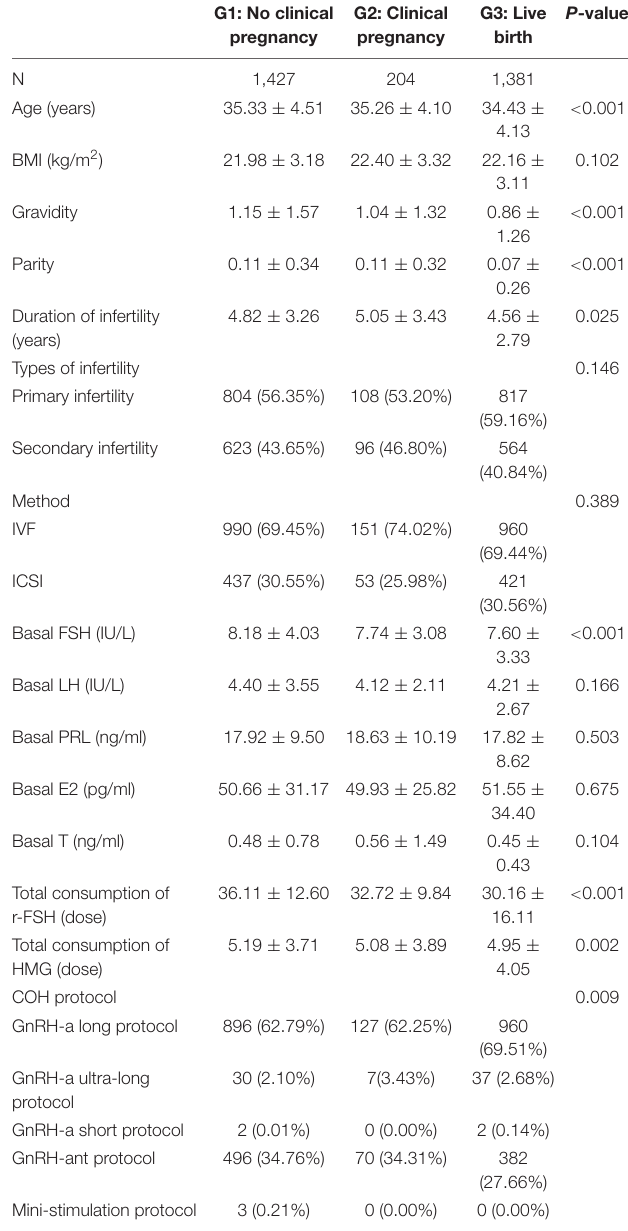
TABLE 1 | Baseline characteristics of